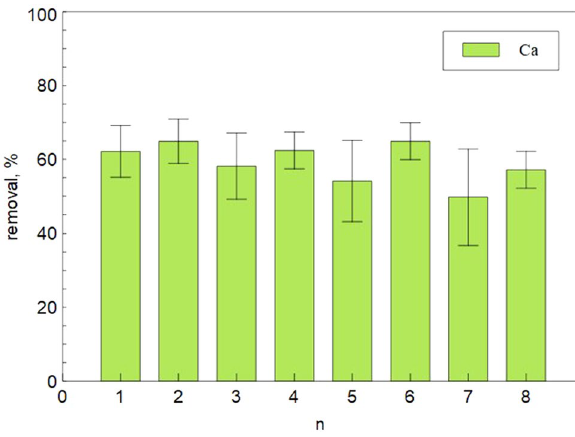
Figure 10. Removal efficiency after subsequent cycles of 4